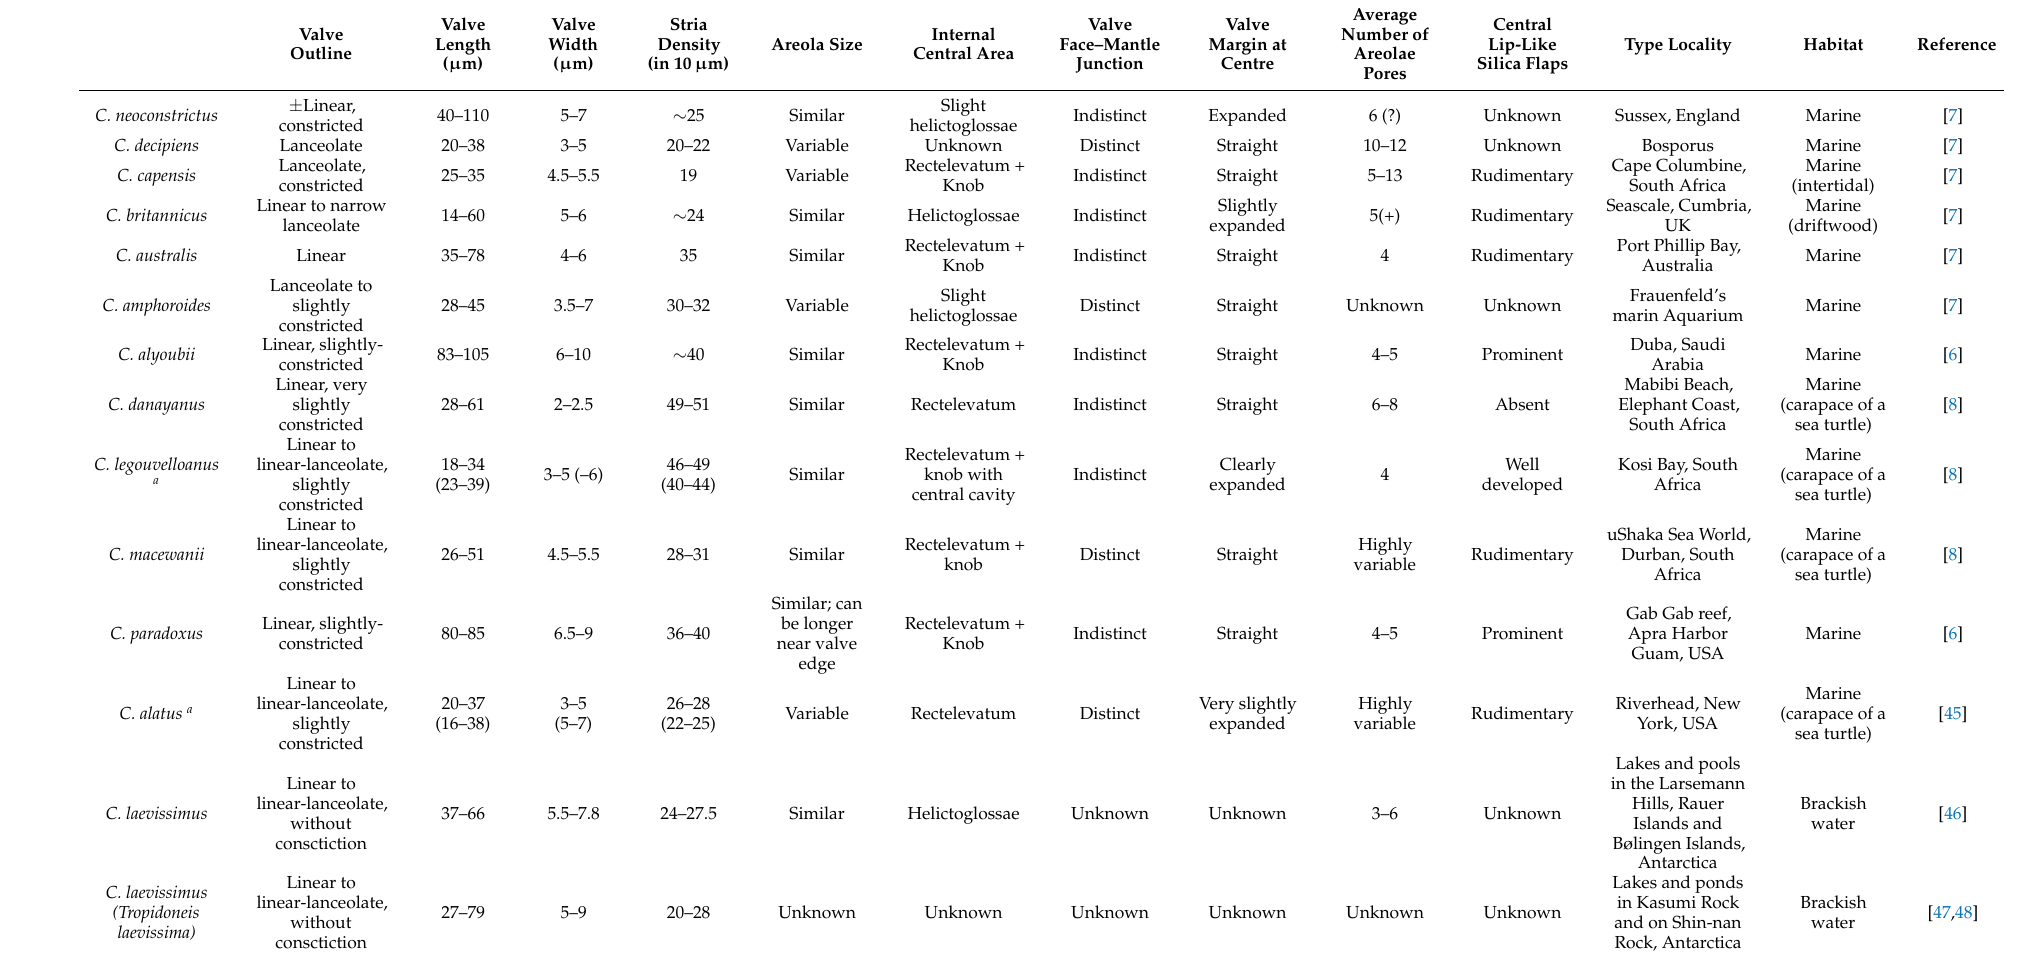
Table 2. Morphological comparison of Craspedostauros